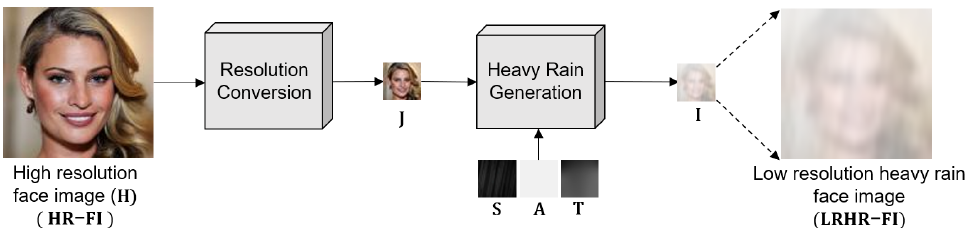
Figure 4. Synthetic LRHR-FI generation based on the proposed scale-aware heavy rain model: Input HR-FI is converted into LRHR-FI through resolution conversion and heavy rain generation.